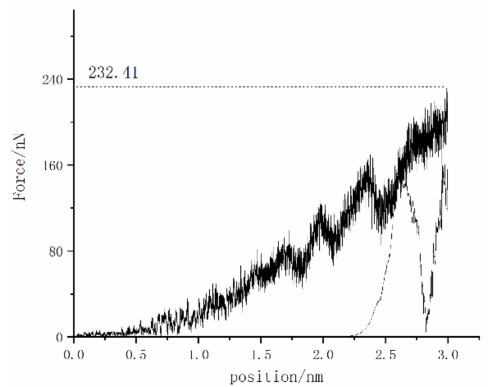
Figure 3. Load–displacement curve of (001) crystal plane